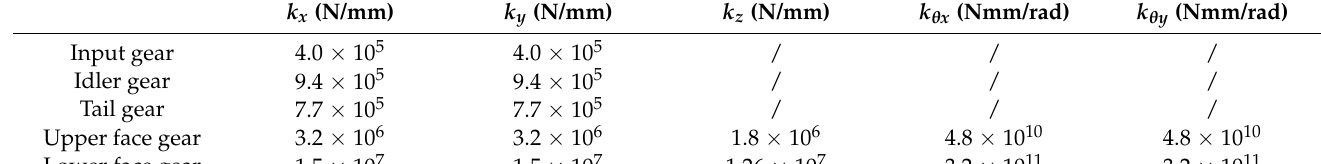
Figure 6. Di ff erence in meshing sti ff ness between fi xed and varying load: ( a ) lower face gear; ( b ) upper face gear.